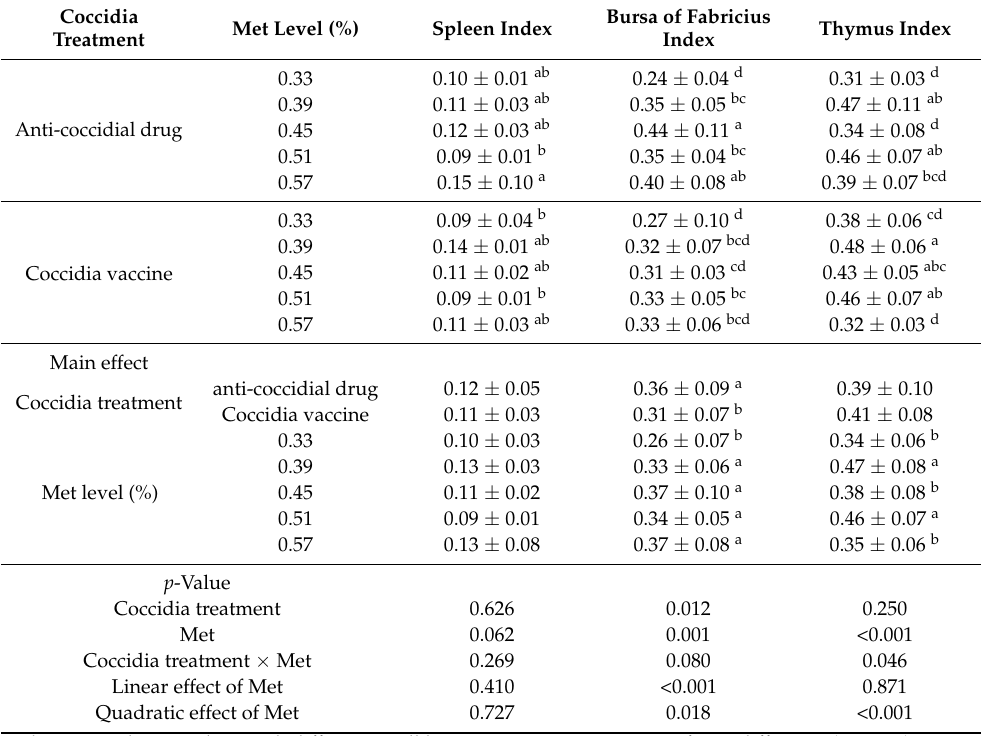
Table 6. Effect of different treatments on immune organ indexes of 1~21 d partridge shank broilers.